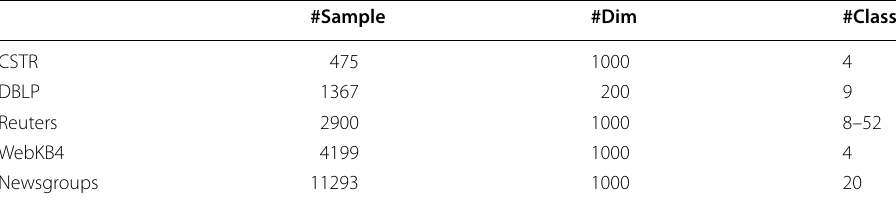
Table 6 Summary of the real-world data sets